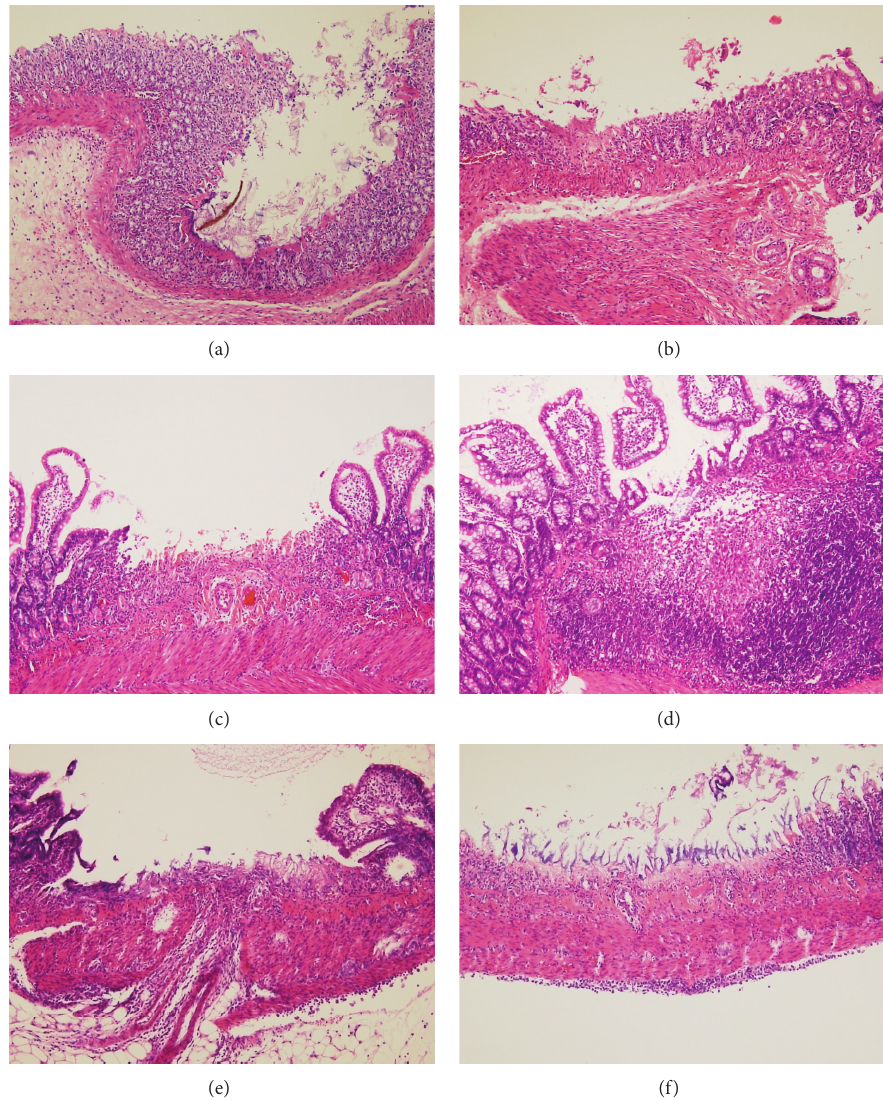
Figure 2: Microscopic findings in the rat small intestine. (a) and (b) Erosions induced by indomethacin showed focal villous necrosis and reduced epithelial height. (c) and (d) Ulcers induced by indomethacin showed deep excavation of mucosa and exposed submucosal layer. Markedinflammatorycellinfiltrationwasnotedinthesubmucosalspace.(e)and(f)Transmuralinflammatoryinfiltrationwaspresentbeyond the ulcer formation (hematoxylin-eosin stain, ×